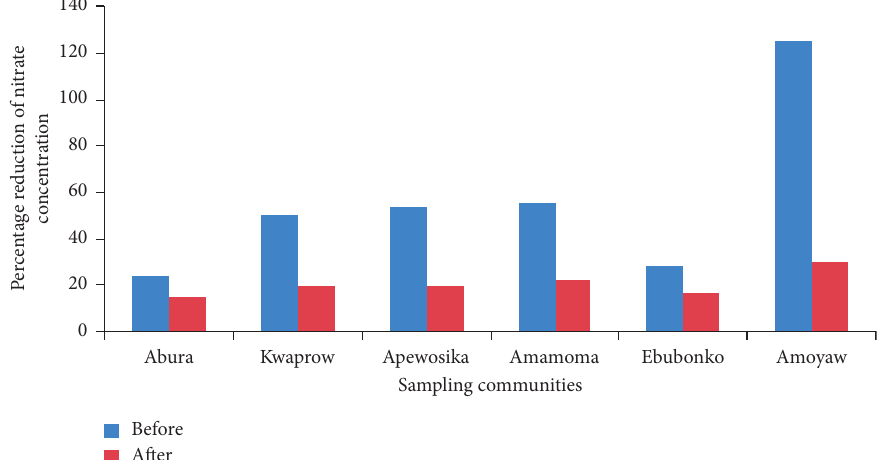
Figure 5: A graph of percentage reduction in nitrate concentration after two hours of treatment with ZSM-11.